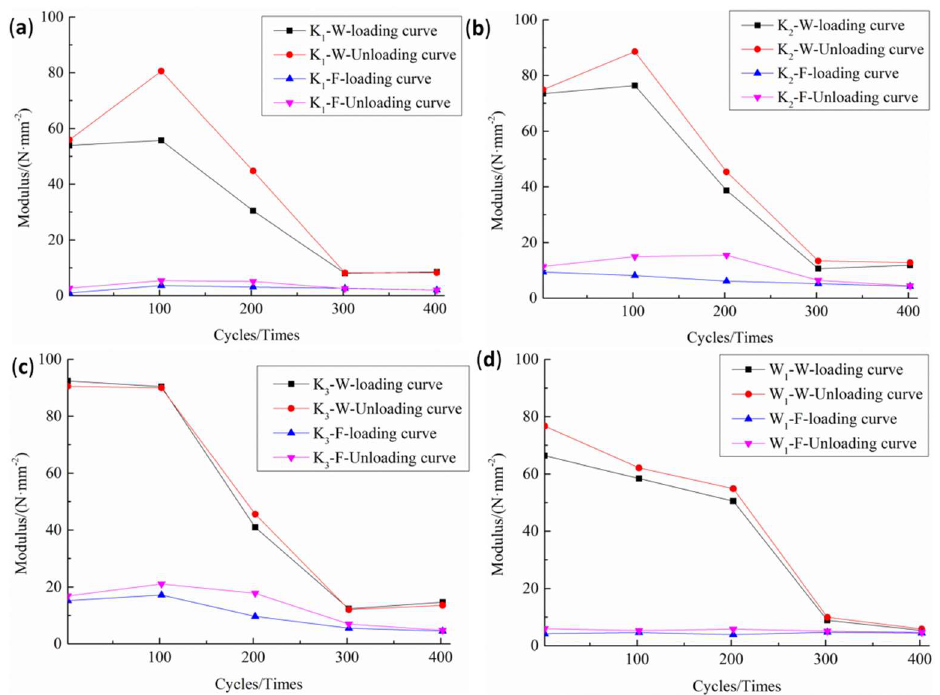
Figure 4. Elastic modulus curves: ( a ) warp and fill specimens of K 1 ; ( b ) warp and fill specimens of K 2 ; ( c ) warp and fill specimens of K 3 ; and ( d ) warp and fill specimens of W 1 .